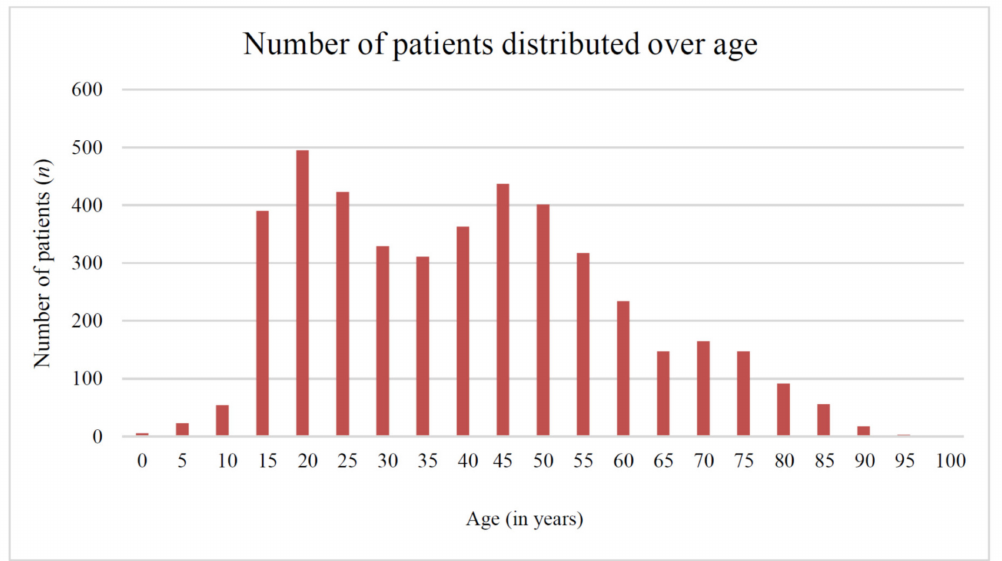
Figure 1. Age distribution of patients with knee ligament injuries (each column represents a 5-year interval).